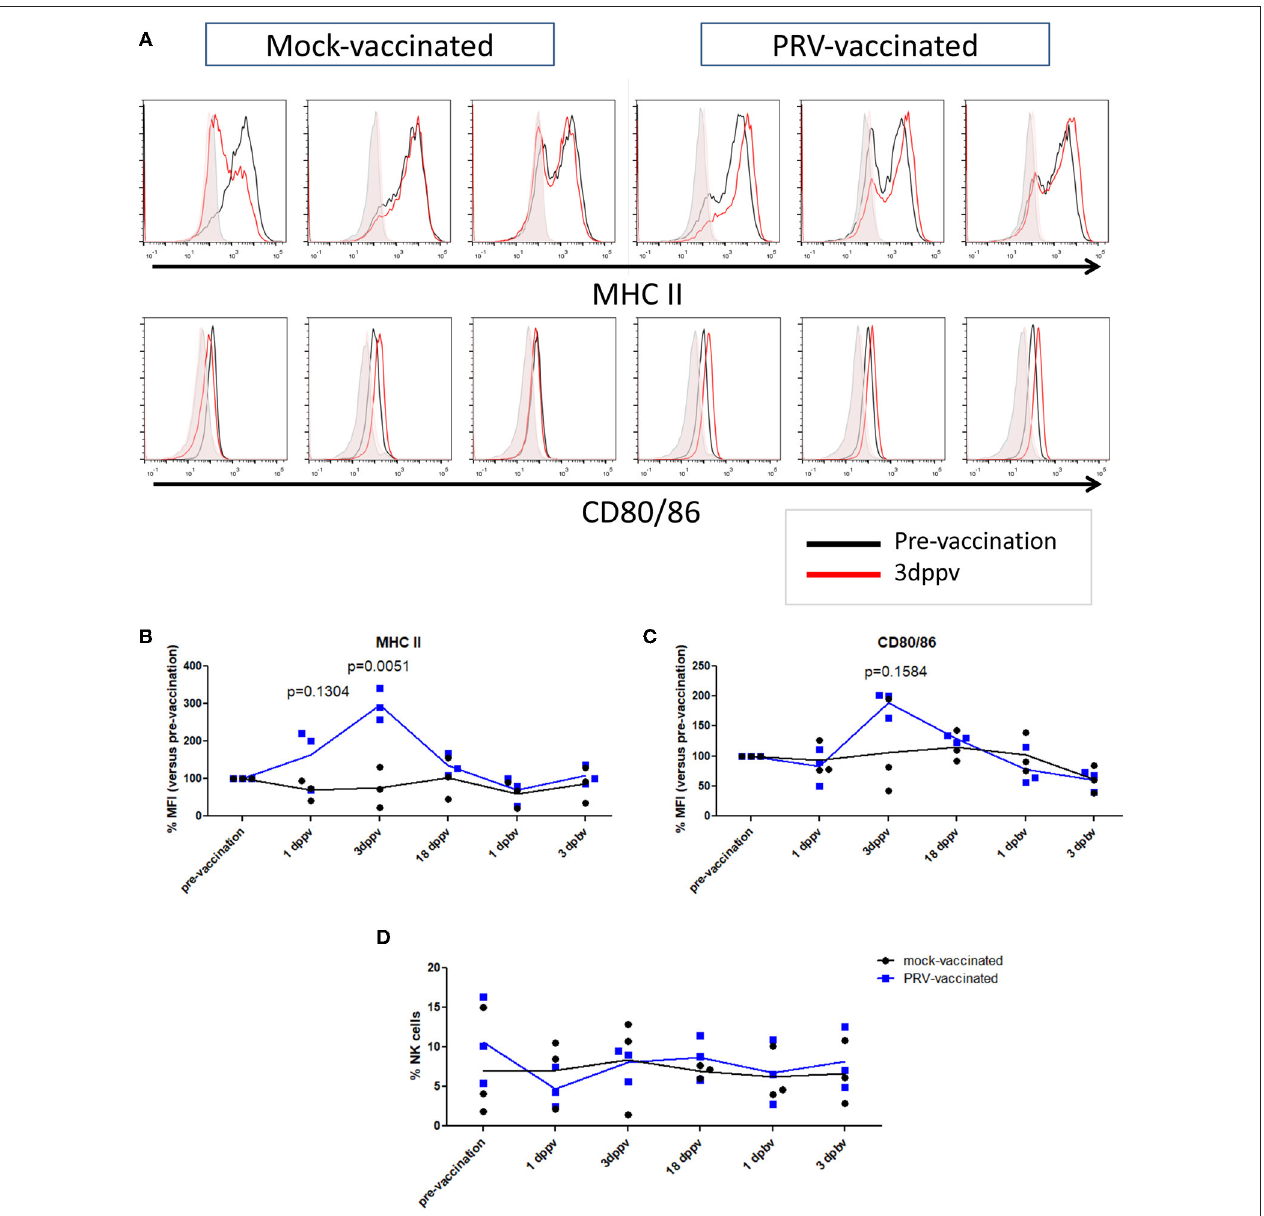
FIGURE 3 | MHC II and CD80/86 expression on porcine NK cells before vaccination and after primary and booster vaccination. (A) Histograms show MHC II (upper panel) and CD80/86 (lower panel) expression on NK cells within the PBMC population before vaccination (pre-vaccination) and 3 days post primary vaccination (dppv). An overlay of the signals (pre-vaccination: black open histogram; 3 dppv: red open histogram) and isotype controls (pre-vaccination: gray shaded histogram; 3 dppv: red shaded histogram) of three mock-vaccinated animals (left) and three PRV-vaccinated animals (right) is shown. Graphs show MFI values of MHC II (B) and CD80/86 (C) expression on porcine NK cells before vaccination, 1, 3, and 18 days post primary vaccination and 1 and 3 days post booster vaccination. The MFI value of the time point before vaccination was set to 100% and the following time points were compared with the time point before vaccination. (D) Dot plot shows the percentage of NK cells within the PBMC population before vaccination, 1, 3, and 18 days post primary vaccination and 1 and 3 days post booster vaccination. Dot plot shows the results of three animals of each group (mock-vaccinated and PRV-vaccinated group) and the mean values are connected with a line. P -value threshold for statistically significant differences was 0.05, p -values are indicated in the graphs (dppv, day(s) post-primary vaccination; dpbv, day(s) post-booster vaccination).